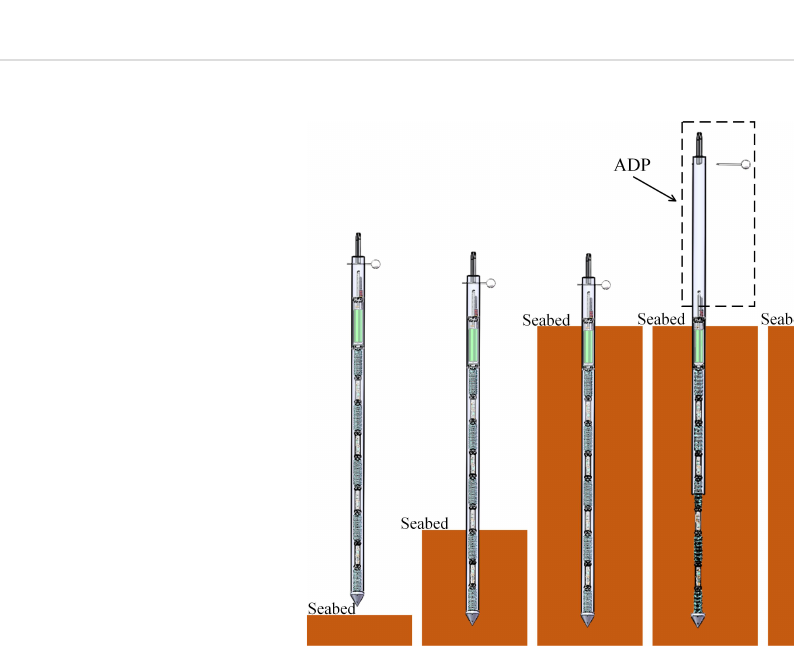
FIGURE 2 The deployment process of the instrument.